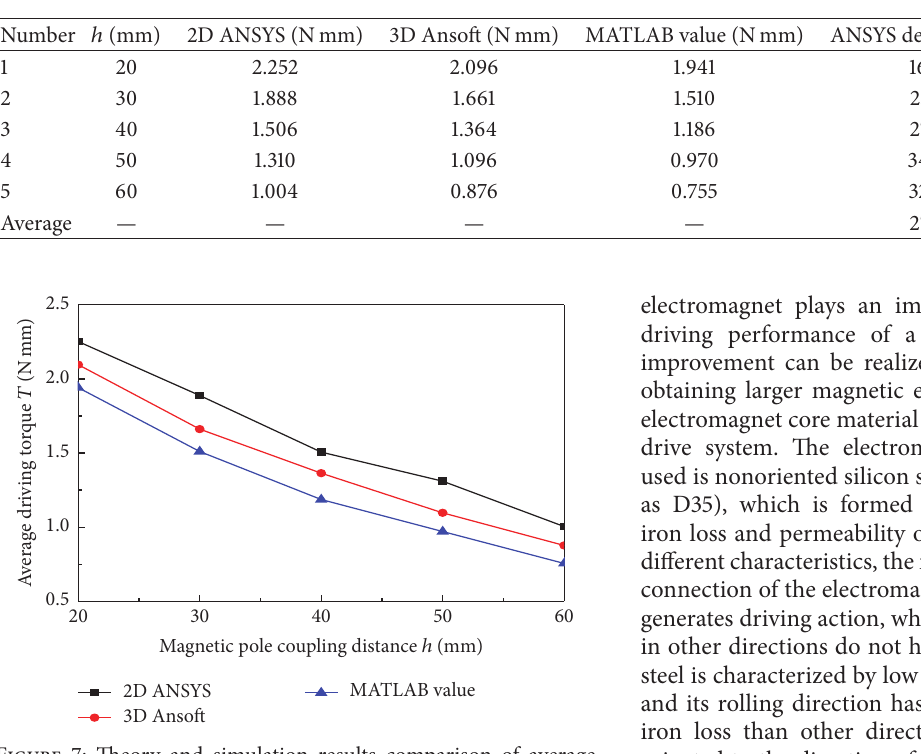
Table 1: Theory and simulation result of average driving torque.